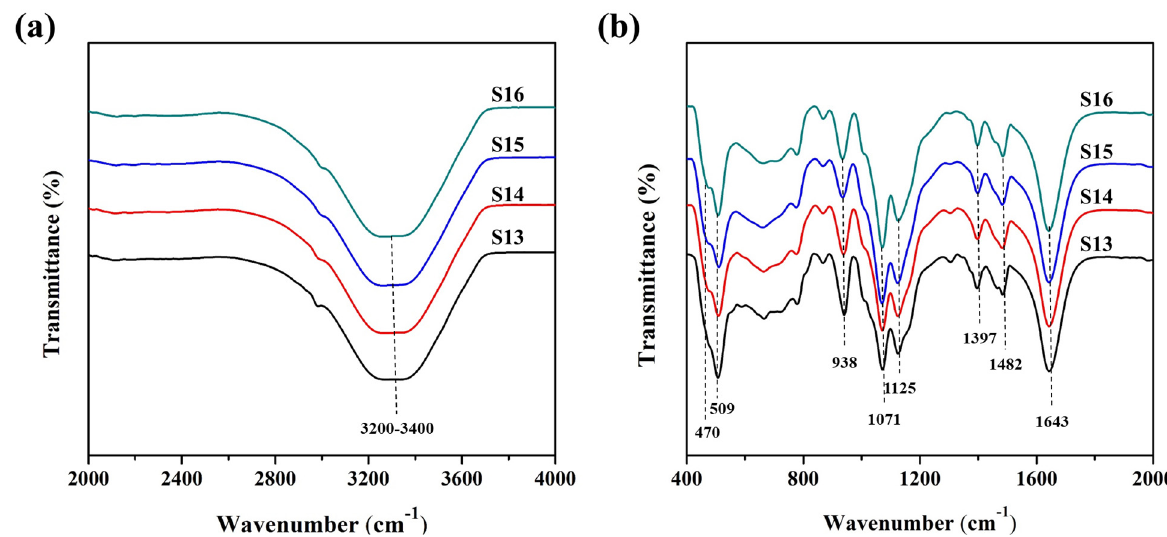
Figure 6. FTIR of the gels prepared with different phosphoric acid addition time (S13-S16): ( a ) 2000 − 4000 cm - 1 , and ( b ) 400 − 2000 cm -1.